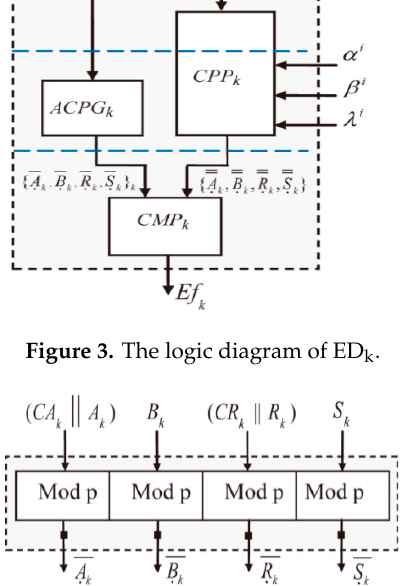
Figure 5. The logic diagram of CPP k.